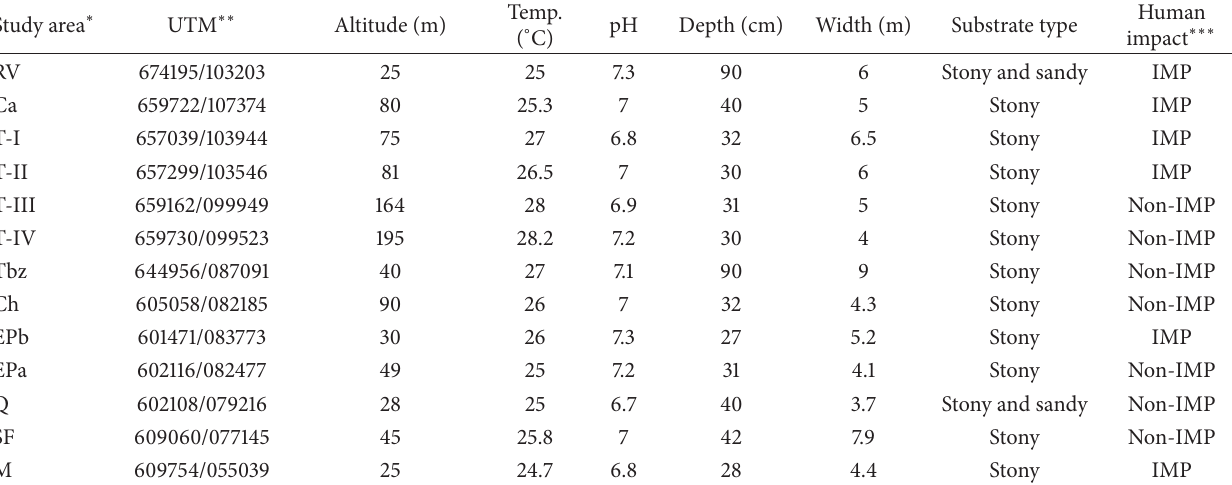
Table 1: Some characteristics of the streams included in the study.